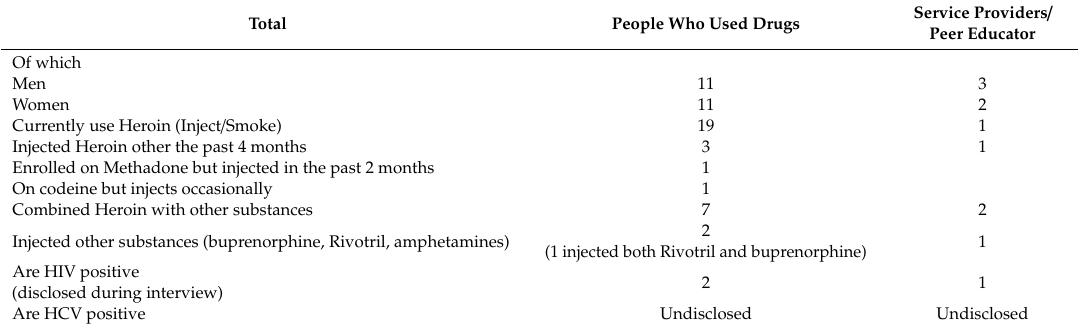
Table 1. Participant categories, N = 27.